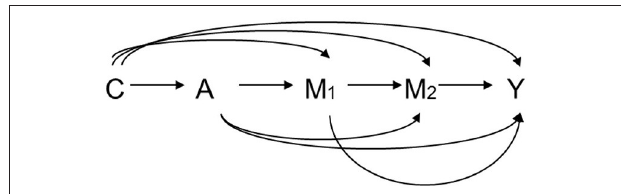
FIGURE 3 | Relation among exposure A, two ordering mediators M 1 and M 2 , outcome Y, and covariates C. A: exposure, M 1 : the first mediator, M 2 : the second mediator, Y: outcome, C: